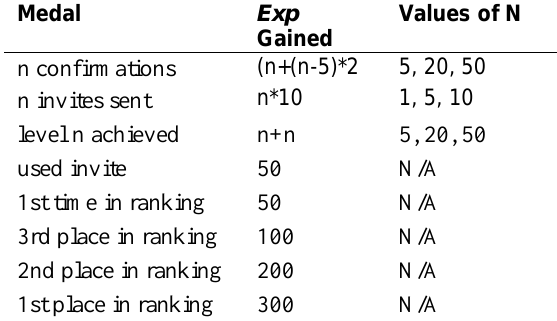
Table 2. Currently Implemented Medals and